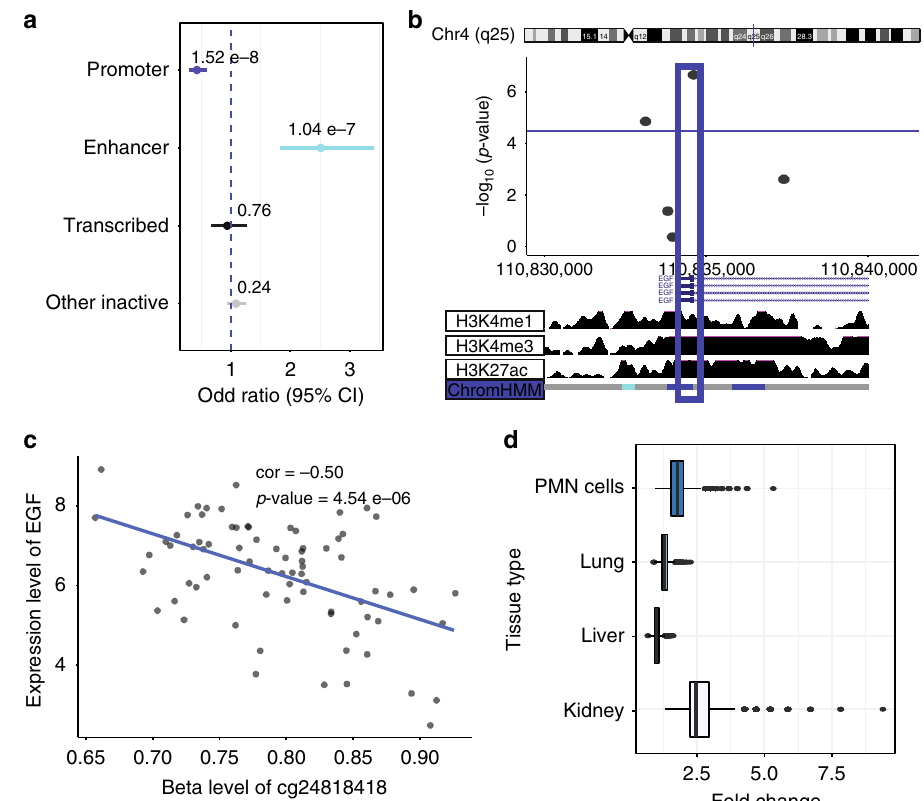
Fig. 4 Functional annotation of probes associated with kidney function decline. Methylation probes that signi fi cantly improve weighted linear regression model of kidney function decline (FDR < 0.05) ( n = 471 CpG probes) were annotated by their regulatory region location. a Odds ratios and signi fi cance was calculated based on all array probes used in the regression analysis ( n = 321,473). Probe locations where methylation level improved the baseline kidney function decline model are enriched on kidney enhancer regions OR = 2.51 (95% CI 1.82 – 3.40, p -value = 1.04 e − 7) using a two-sided fi sher exact test. Blue dashed line indicates OR = 1. b Locus zoom for one CpG probe (cg24818418) that improved the baseline kidney function decline model located in kidney promoter region. Chromosome and track images are from UCSC genome browser build hg19 (http://genome.ucsc.edu). c Methylation probe (cg24818418) associated with EGF gene expression level using Pearson correlation test. Unadjusted correlation = -0.50 ( p -value = 4.54 e − 06). d Methylation probes that signi fi cantly improve model of kidney function decline (FDR < 0.05) ( n = 471 CpG probes) were annotated to tissue speci fi c enhancer region. Fold change compared observed number of signi fi cant probes located in each tissue speci fi c enhancer region to the distribution of random 471 probes selected 10,000 times from the background of all array probes used in the regression analysis ( n = 321,473). Median fold change for kidney enhancer was 2.47. Median fold change for liver enhancer was 1.00. Median fold change for lung was 1.30. Median fold change for polymorphonuclear (PMN) cells was 1.78. (Center line, median fold change; box limits, upper and lower quartiles; whiskers, 1.5× interquartile range)